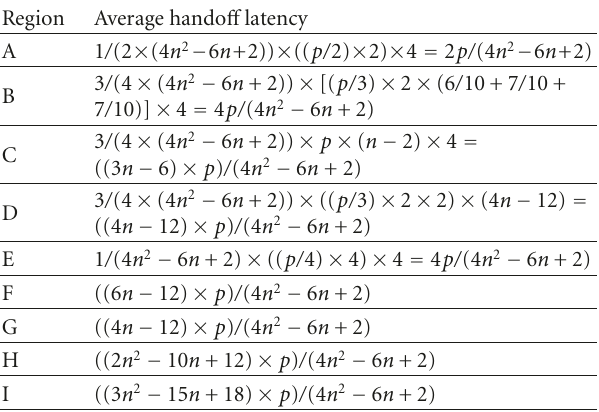
Table 2: Average hando ff latency derived by the regions where the THA located. Region Average hando ff